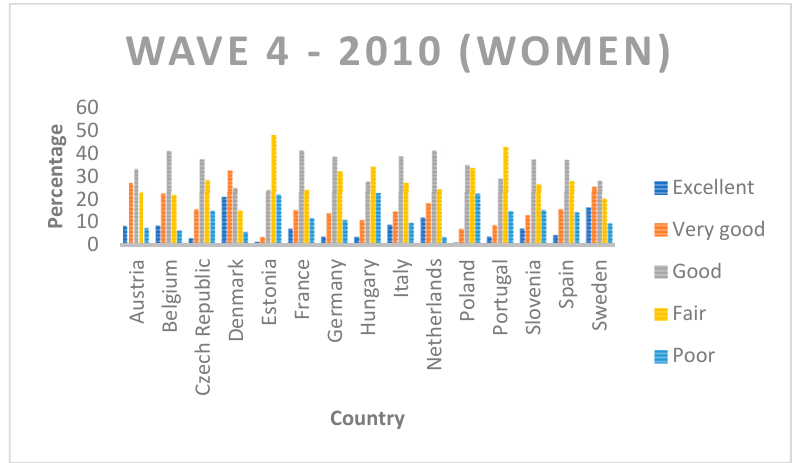
Figure A5. Distribution of men in Wave 8 (2020). Source: Authors’ elaboration based on SHARE (2021). Figure A6. Distribution of women in Wave 8 (2020). Source: Authors’ elaboration based on SHARE (2021). References 1.